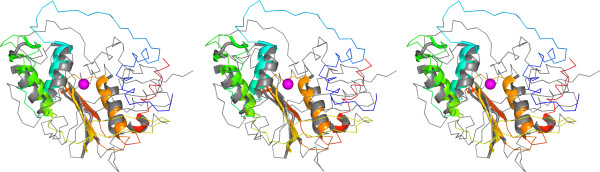
Stereo structural superposition of the nuclease(-like) domains of RecB and RecC produced with LSQMAN [29]. RecB is coloured grey while RecC, is coloured in a spectrum from blue (N-terminus) to red (C-terminus). Structurally superposed regions are shown in cartoon representation (rms deviation of 2.19Å for 71 Cα atoms), other parts as a Cα trace. The calcium ion bound to RecB is shown as a magenta sphere.